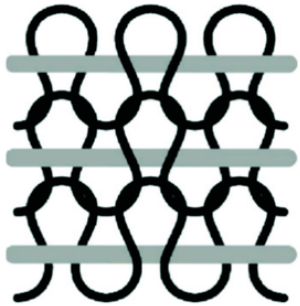
Figure 2. Inlaid yarns (black) embedded in a double jersey structure [32] .